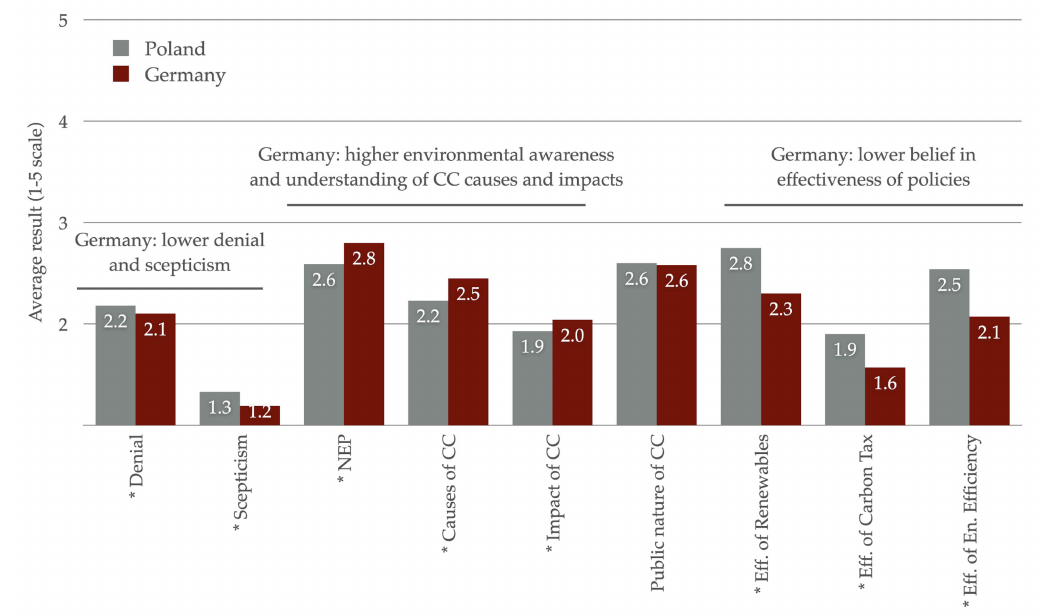
Figure 1. Comparison of average answers on a five-point scale in Poland and Germany. Statistically significant variables, at p < 0.05, are marked with * (Student’s t